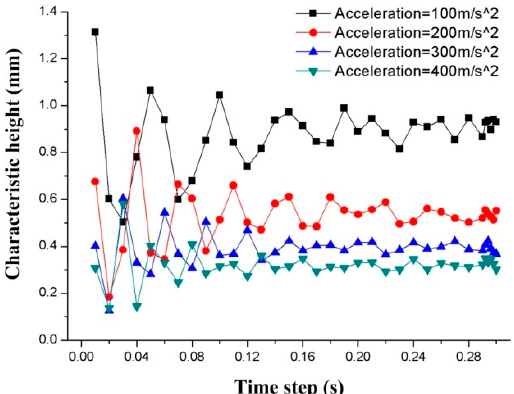
Figure 5. The relationship between characteristic-height (C-height) and the time step in different accelerations. The accelerations are from 100m/s 2 to 400 m/s 2 .